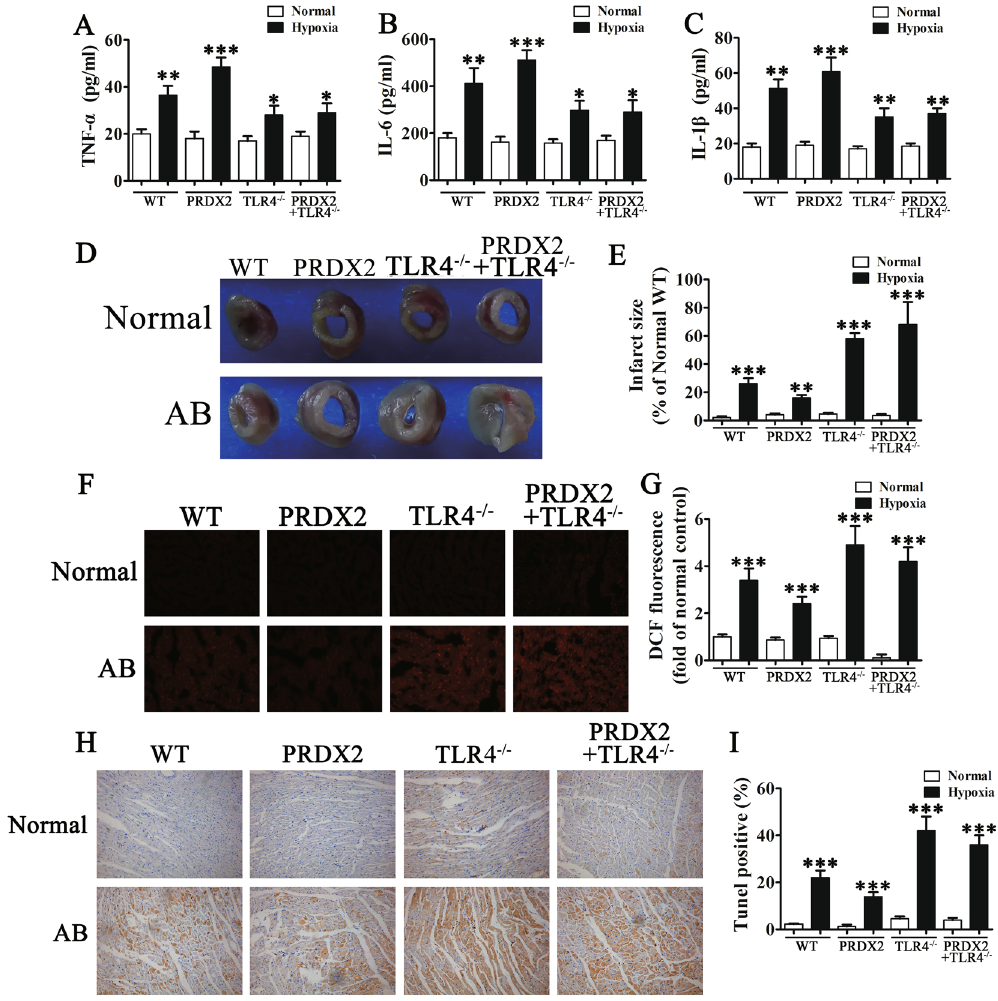
Figure 5. The overexpression of PRDX2 inhibits ROS levels and myocardial injury after AMI but promotes inflammatory responses. After 2 weeks of coronary artery ligation, serum from mice was harvested for ELISA analysis and after 1 month, myocardial tissue was used for immunohistochemical analysis. ( A – C ) ELISA for inflammatory cytokines. The data are presented as means ± SD from three separate experiments from five to six mice in each group. * p < 0.05, ** p < 0.01, *** p < 0.001 vs control. ( D ) Representative images of infarct size as stained by TTC. ( E ) PRDX2 decreased infarct size compared with other groups. The data are presented as means ± SD from five to six separate mice in each group. ** p < 0.01, *** p < 0.001 vs control. ( F ) Immunofluorescence for ROS generation by DCF-DA. ( G ) The results show that the expression of PRDX2 inhibits generation of oxidative stress and the inhibition of PRDX2 on ROS was enhanced with TLR4 knock out. The data are presented as means ± SD from ten separate fields. *** p < 0.001 vs control. ( H and I ) TUNEL analysis of apoptosis in myocardial infarction. Statistical analysis of apoptosis. AB, aortic banding. The data are presented as means ± SD from three separate experiments. *** p < 0.001 vs